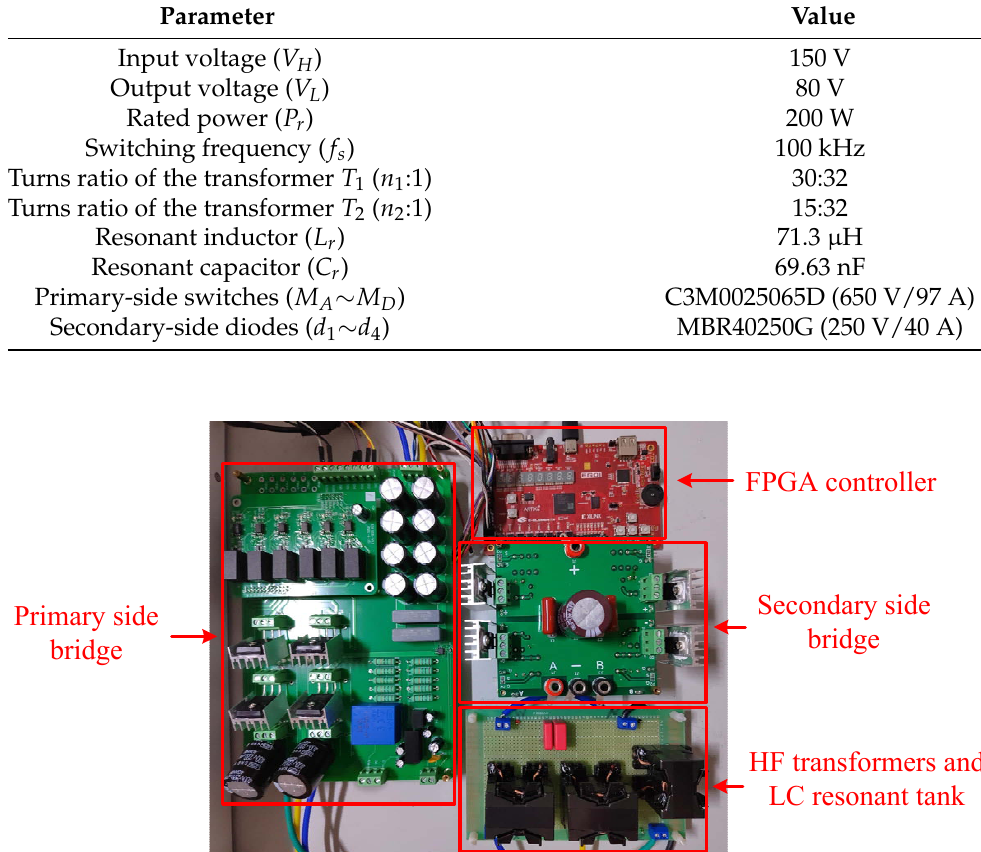
Table 2. Parameters of the prototype.